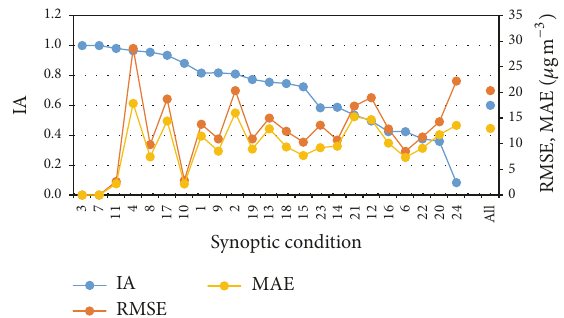
Figure 16: Performance metrics for each synoptic condition (1–24) and considering all cases irrespective of the synoptic condition (shown as All). Synoptic conditions are ranked as explained in Figure